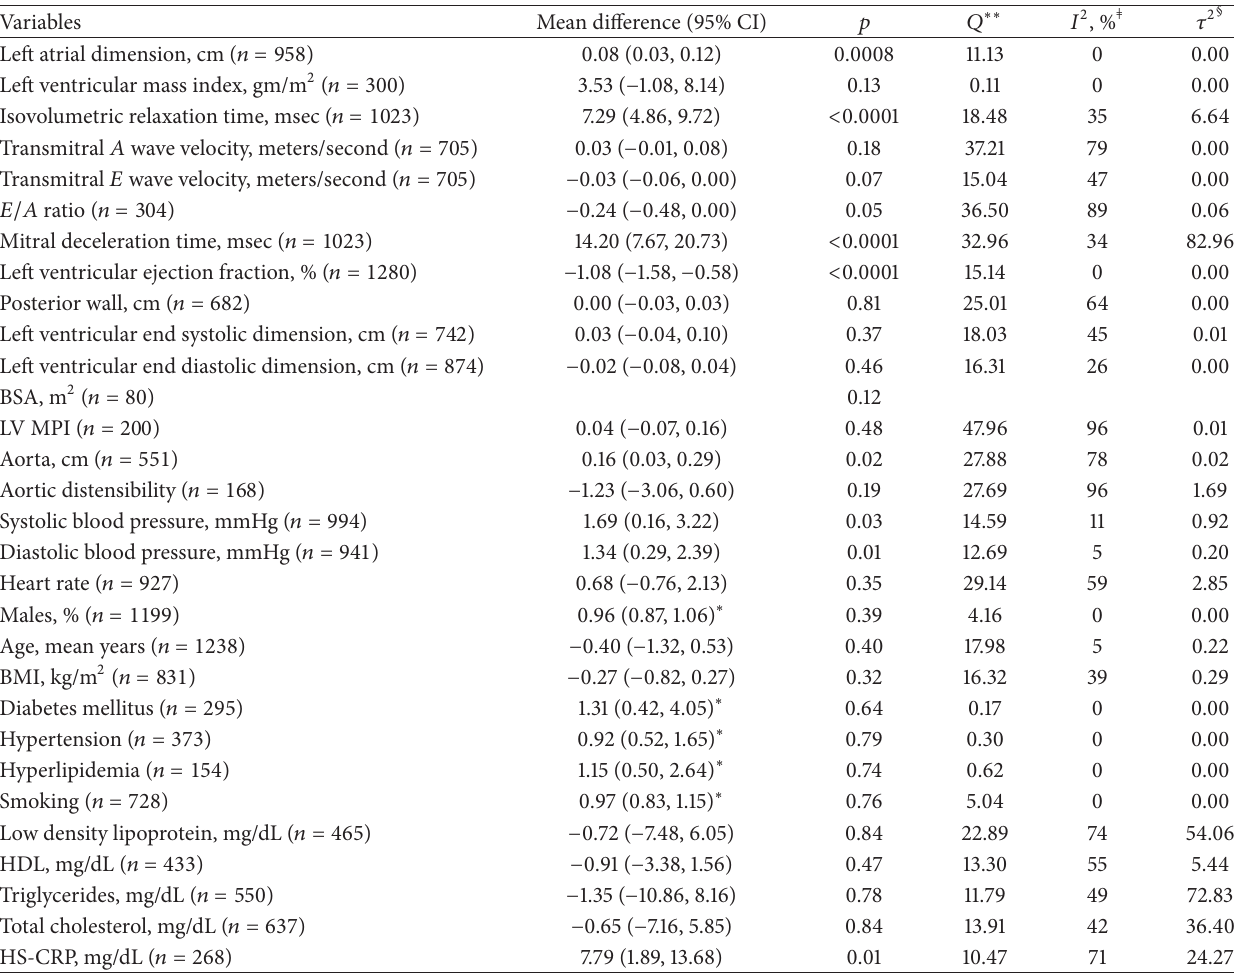
Table 2: Meta-analysis outcomes (random-effects